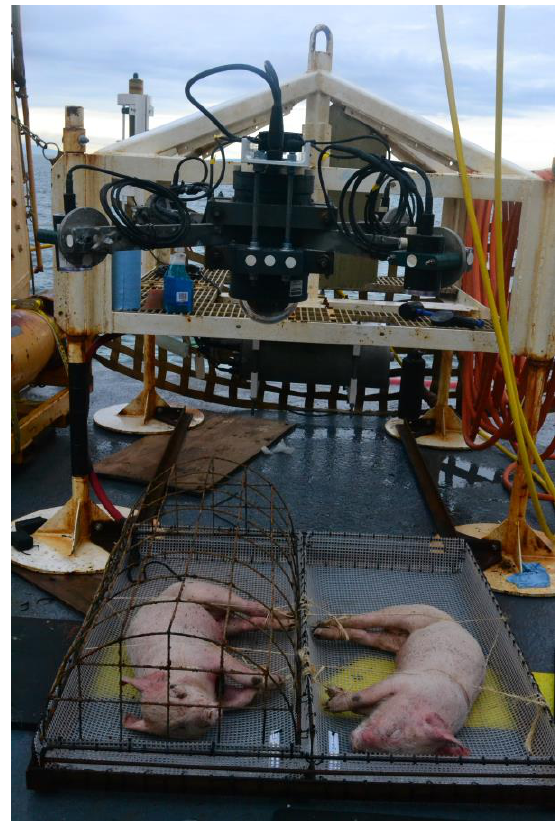
Figure 1. Two pig carcasses on the pig platform, attached to the instrument platform, ready to be deployed. A digital webcam was positioned above the carcasses. Frame, cage, and trays designed by Chris Sundstom and instrument platform designed by Paul Macoun, ONC, VENUS observatory.